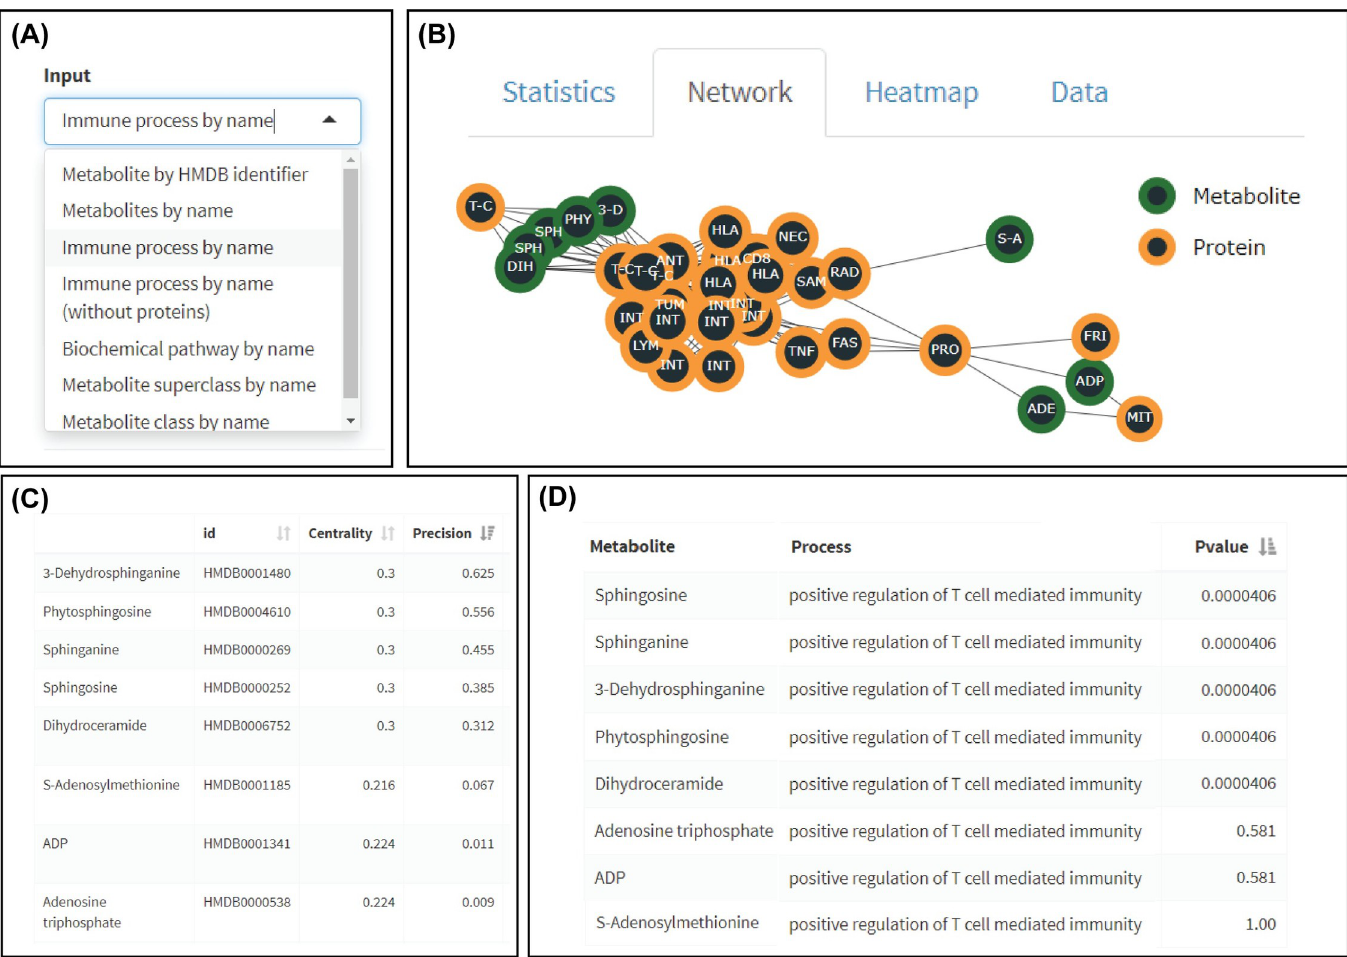
Fig 8. IMA R shiny application concept. (A) The application allows users to enter processes, metabolites, proteins, or identifiers from a list to produce networks and calculate statistics. This flexibility of input possibilities enables to obtain metabolites from immune processes and vice versa. (B) Several visualizations have been included to visualize associations between metabolites and processes. Here, we zoomed in on the connected part of the interaction network of T cell-mediated immunity. (C, D) Example outputs for metabolites associated with positive regulation of T cell-mediated immunity including centrality, precision, and p-values.